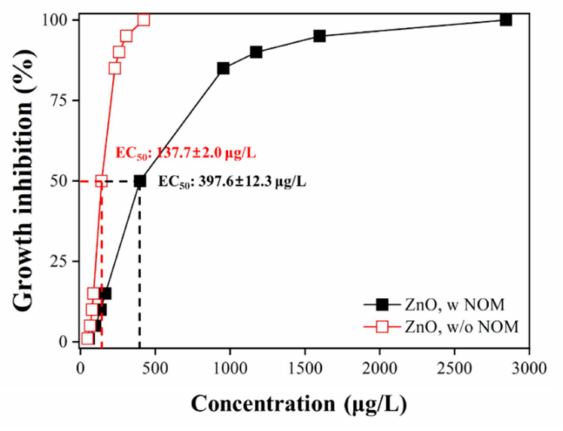
Figure 7. Algae growth inhibition by ZnO NPs with / without